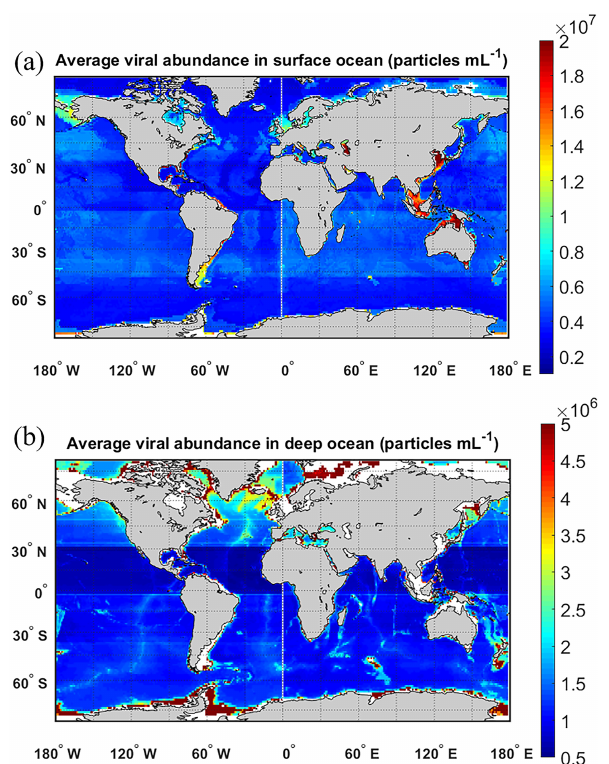
Figure A1. Viral abundance projected using the random forest, showing average in (a) surface ( ≤ 200m) and (b) deep ( > 200m)